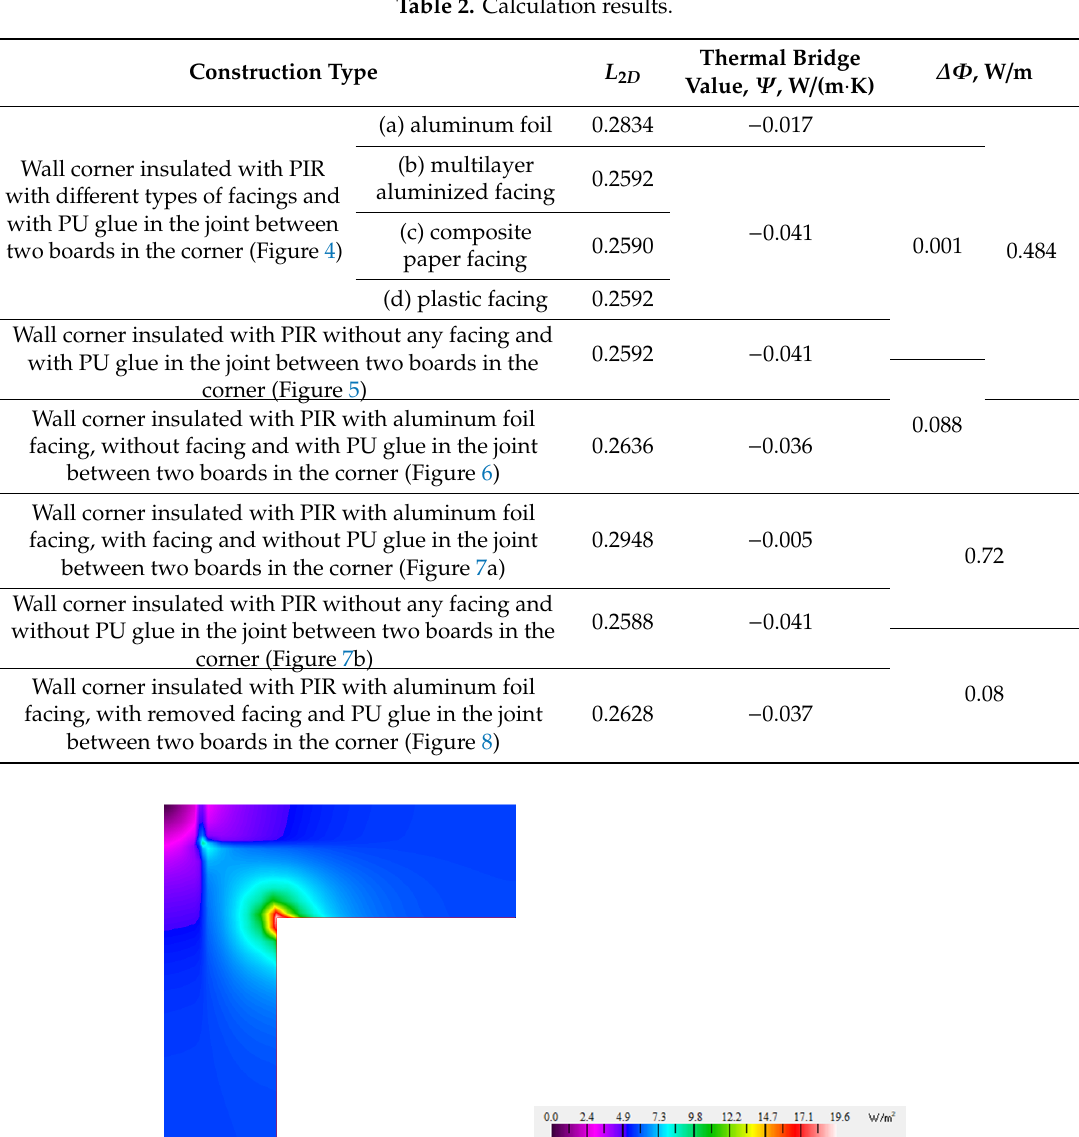
Figure 6. The heat flow rate through the wall corner insulated with aluminum foil-faced PIR, without aluminum foil at the joint between boards and with PU glue in the joint. Since PU glue is not commonly used in the joint, we considered the situation where the aluminum foil facing in the joint is in contact with both PIR insulation aluminum foil facings on the outside and at the inside surfaces of adjacent PIR board. For comparison, another simulation for PIR without facing and without PU glue was performed. The simulation results are presented in Figure 7.